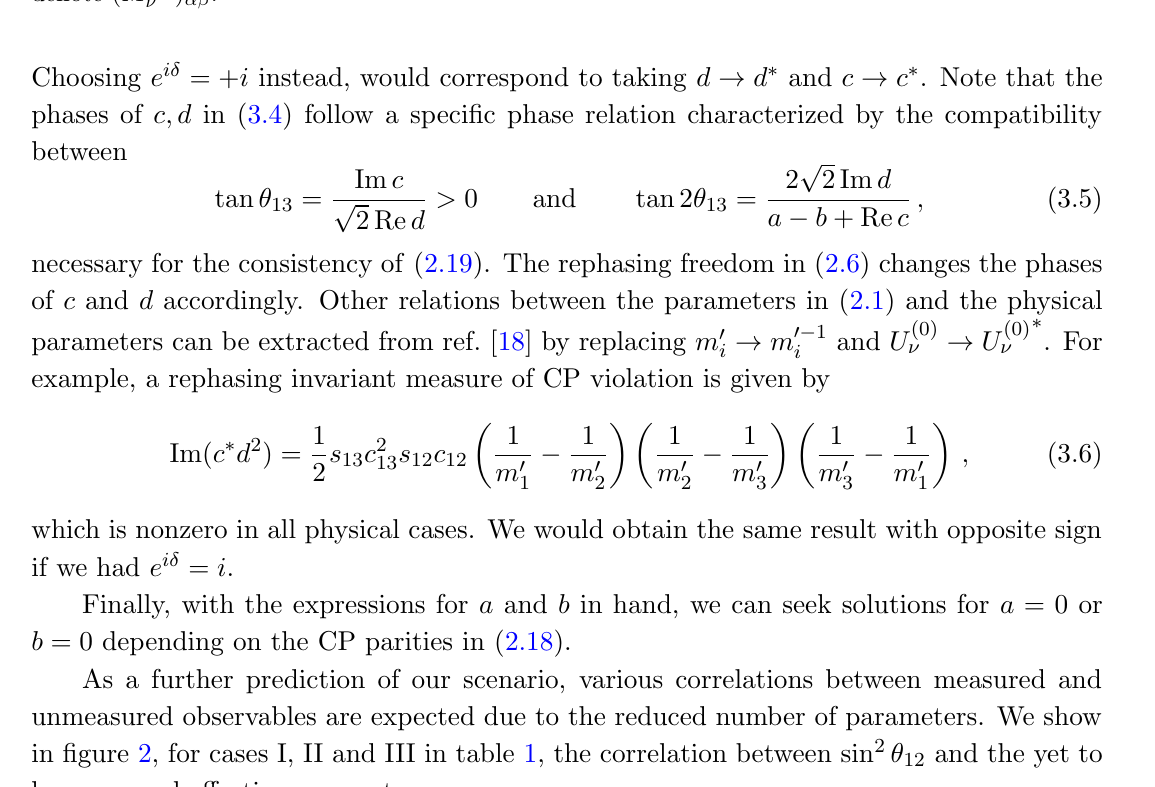
Figure 2 . Correlation between sin 2 (cid:18) 12 and m (cid:12)(cid:12) for CP (cid:22)(cid:28) symmetric neutrino mass matrix with one-zero textures in M (cid:0) 1 . The oscillation observables are varied within 3- (cid:27) of ref. [56] and A (cid:11)(cid:12) (cid:23) denote ( M (cid:0) 1 ) (cid:11)(cid:12) (cid:23)